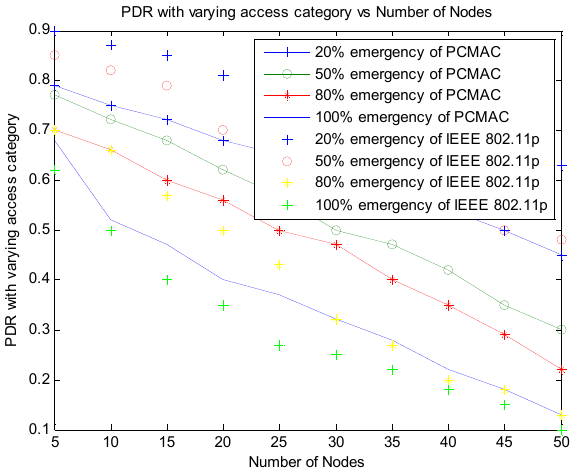
Figure 11. Comparison of PDR of PCMAC and RMAC with varying emergency packets.